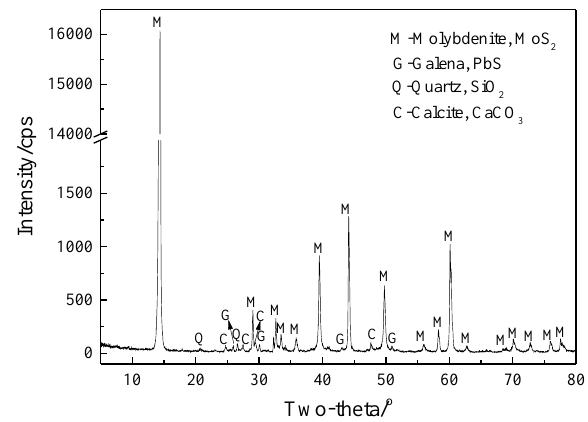
Figure 1. XRD pattern of the lead-rich molybdenum concentrate.